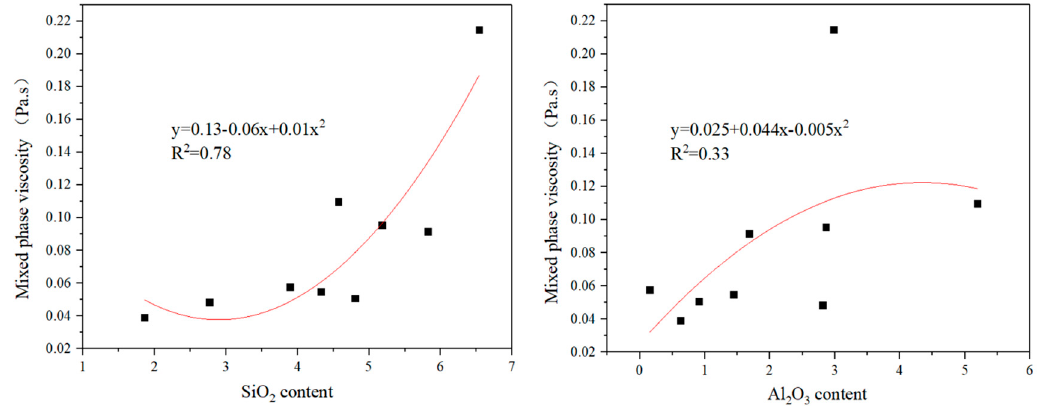
Figure 10. Relationship between the mixed phase viscosity and gangue content: ( a ) SiO 2 content and ( b ) Al 2 O 3 content.